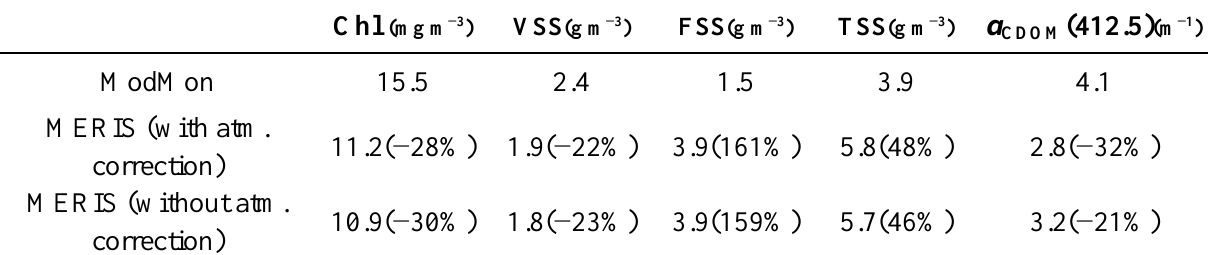
Table 2. Results comparing predicted (MERIS) versus measured (ModMon) WQCs values for NRE station #120 both with (upper row) and without (lower row) atmospheric correction. ModMon data were collected on 14 October 2008 at 09:40 AM EST and the MERIS overpass occurred at 10:25 AM EST. The numbers in parentheses are the MERIS WQCs errors relative to the ModMon